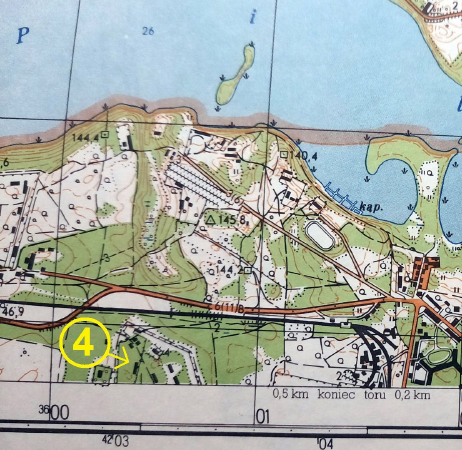
Fig. 10. Part of the Borne Sulinowo garrison on the 1:25,000 map (Krągi sheet) with complete military